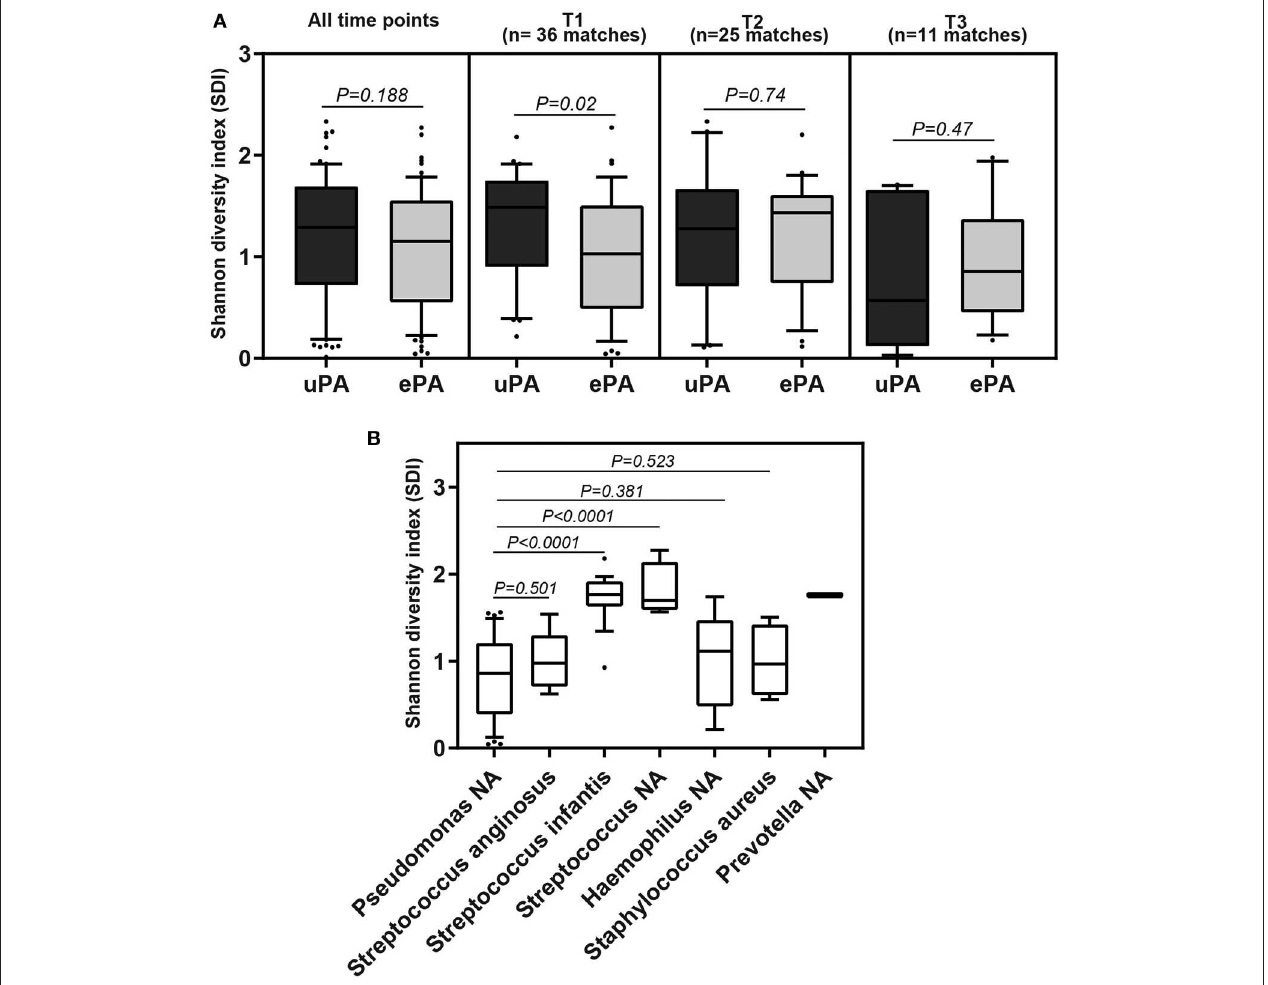
FIGURE 4 | Alpha diversity from sputum samples from CF patients. Boxplot comparison of the alpha-diversity by PA strain type: epidemic (ePA) and no-epidemic P. aeruginosa (uPA) at all-time points, time 1, time 2 and time 3 point (A) , and by the most abundant OTUs found in the microbial communities at time 1 (B) . For those that have NA means that based on the sequencing results cannot be assigned to the species level. The median and interquartile ranges (IQR) are indicated as the middle, top and bottom lines of each box. Ends of the whiskers mark the 10 and 90 percentile in each box. Wilcoxon rank-sum (Mann-Whitney) tests were